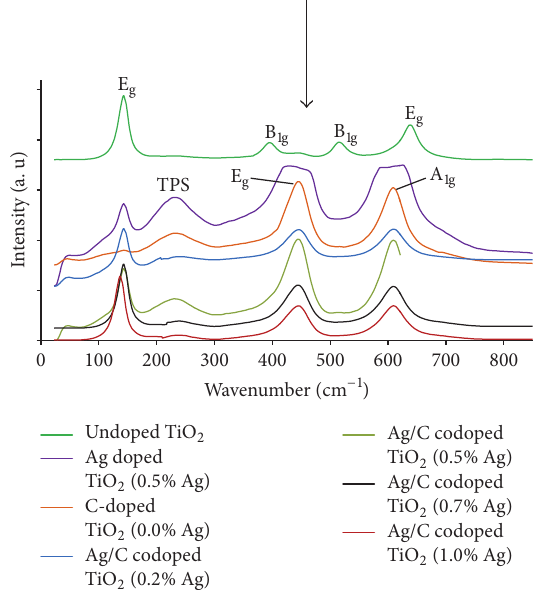
Figure 3: Raman spectra of undoped TiO 2 , Ag doped TiO 2 , and Ag/ C codoped TiO 2 photocatalysts with different contents of